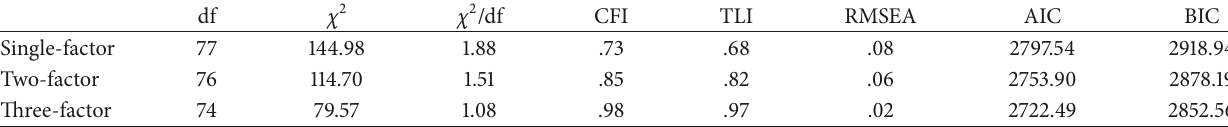
Table 2: Goodness-of-fit indices for three models ( 𝑁 = 134 ).